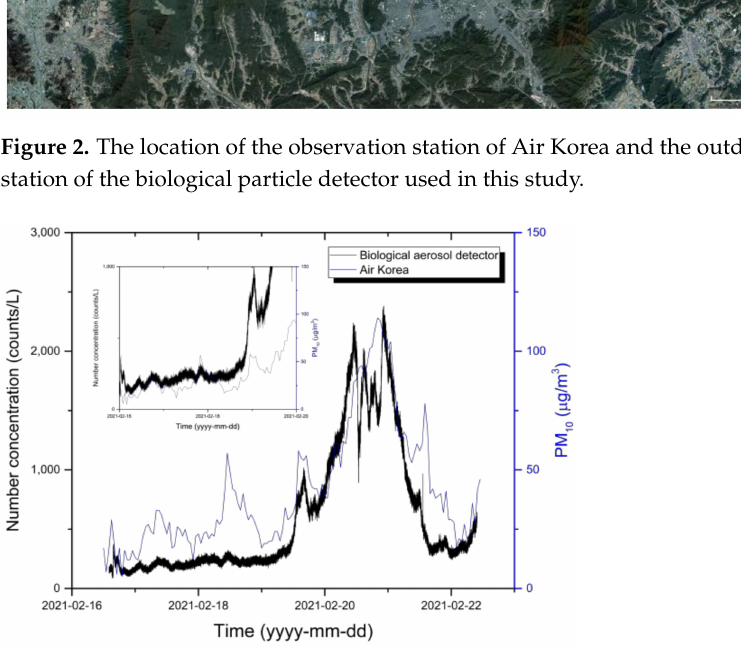
Figure 3. Comparison of Air Korea data with the particle measurement results of our biological particle detector to verify its reliability. The X-axis represents the measurement period, and the Y-axis represents the measured particle concentrations, respectively. The blue line represents the particle observation results from Air Korea, and the black line represents the particle concentrations (counts/L) of the biological particle